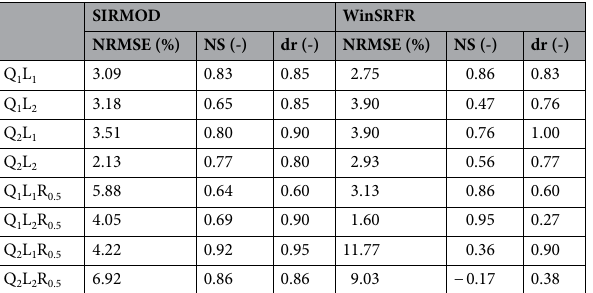
Table 6. Evaluation of the infiltrated water depth by the SIRMOD and WinSRFR models in continuous and surge irrigations based on statistical indicators. Q: stream size; L: furrow length; R 0.5 : surge irrigation with cycle ratio of